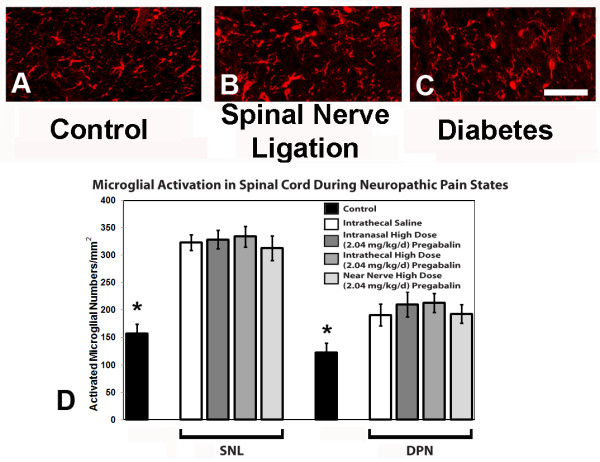
Microglia Assessment. Microglia accumulation was assessed in the dorsal regions of thoracic and lumbar spinal cord for control rat spinal cord (A), and with either spinal nerve ligation (B) or diabetic peripheral neuropathy (C) in rats. Greater immunohistochemically-identified accumulation and activation of microglia in the dorsal spinal cord of rats was seen with spinal nerve ligation or diabetic peripheral neuropathy (D) without impact of pregabalin delivery.* indicates significant differences between control (sham SNL surgery or citrate-injected non-diabetic rat respectively) and all SNL and DPN rat values using individual unmatched ANOVA testing (p < 0.0125 after Bonferroni corrections). Bar = 50 μm.